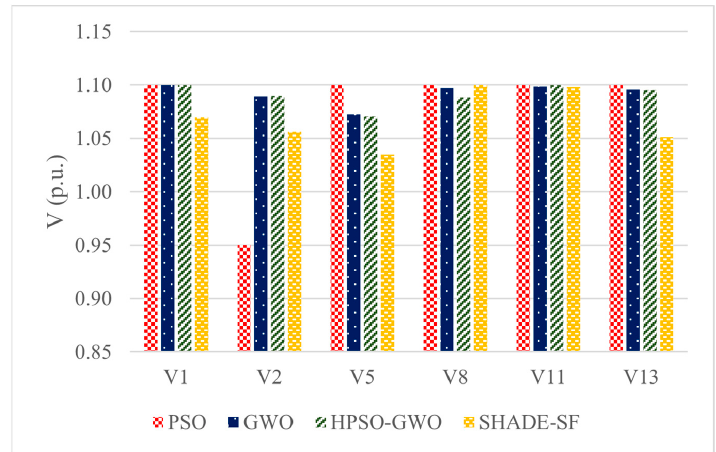
Figure 26. Generator bus voltages comparison (Case 5).